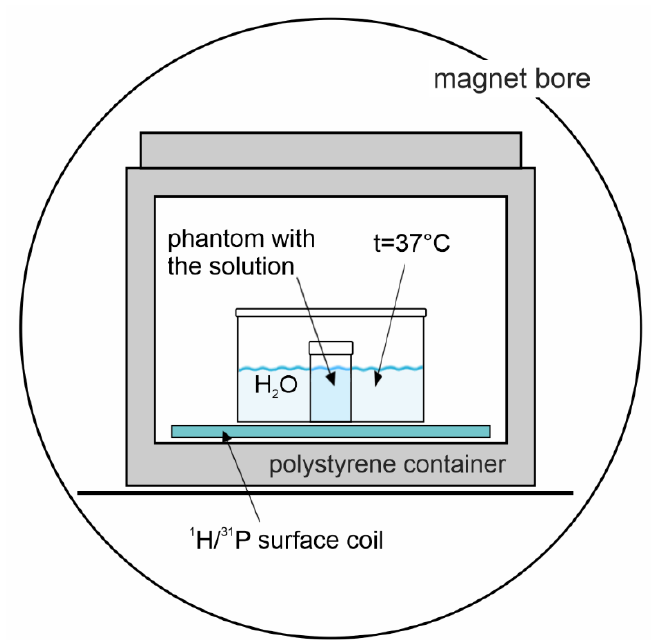
Figure 2. Arrangement of the phantom 31 P MRS experiment. A plastic bucket filled with water keeps the temperature and loading of the coil.